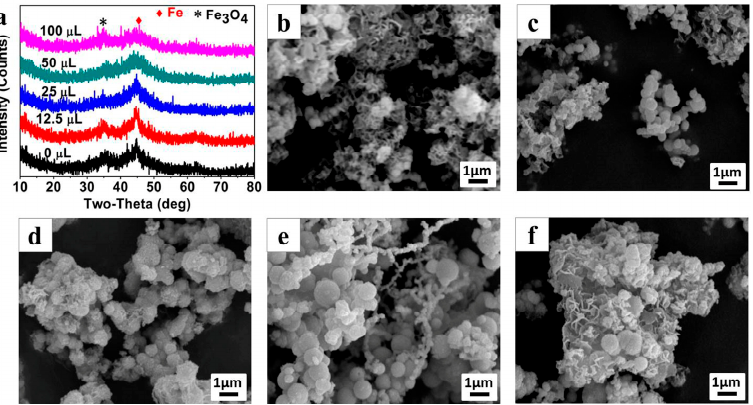
Figure 3. XRD patterns ( a ), SEM images ( b – f ) of Fe 0 /Fe 3 O 4 microparticles synthesized under different NVP addition with a fixed AMPS addition of 0.05 g: ( b ) P 0.05 0 , ( c ) P 0.05 12.5 , ( d ) P 0.05 25 , ( e ) P 0.05 50 , and ( f ) P 0.05 100 ,